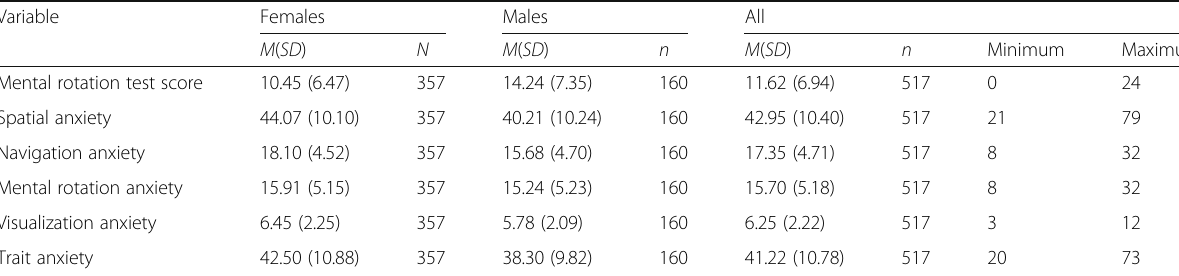
Table 2 Means and standard deviations of the variables by gender Variable Females Males M ( SD ) N